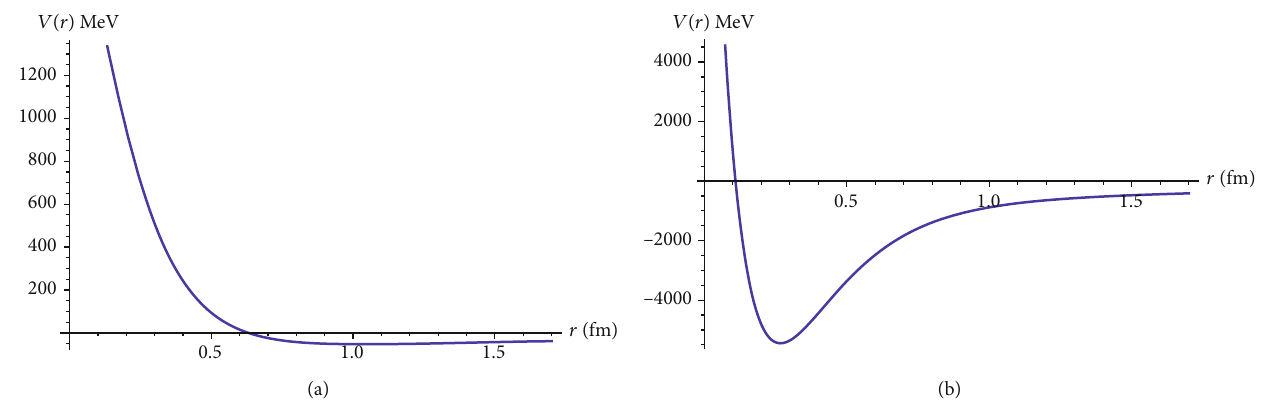
Figure 6: The potential with GY and SPED functions, respectively, of 4 He nuclei as OBEP through the exchange of π , σ , and ω mesons, with parameter I.